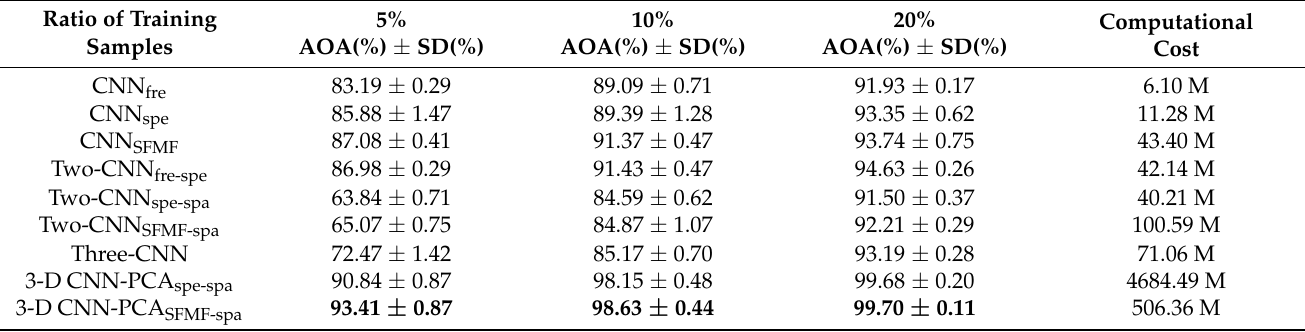
Table 4. Classification results of Botswana image.